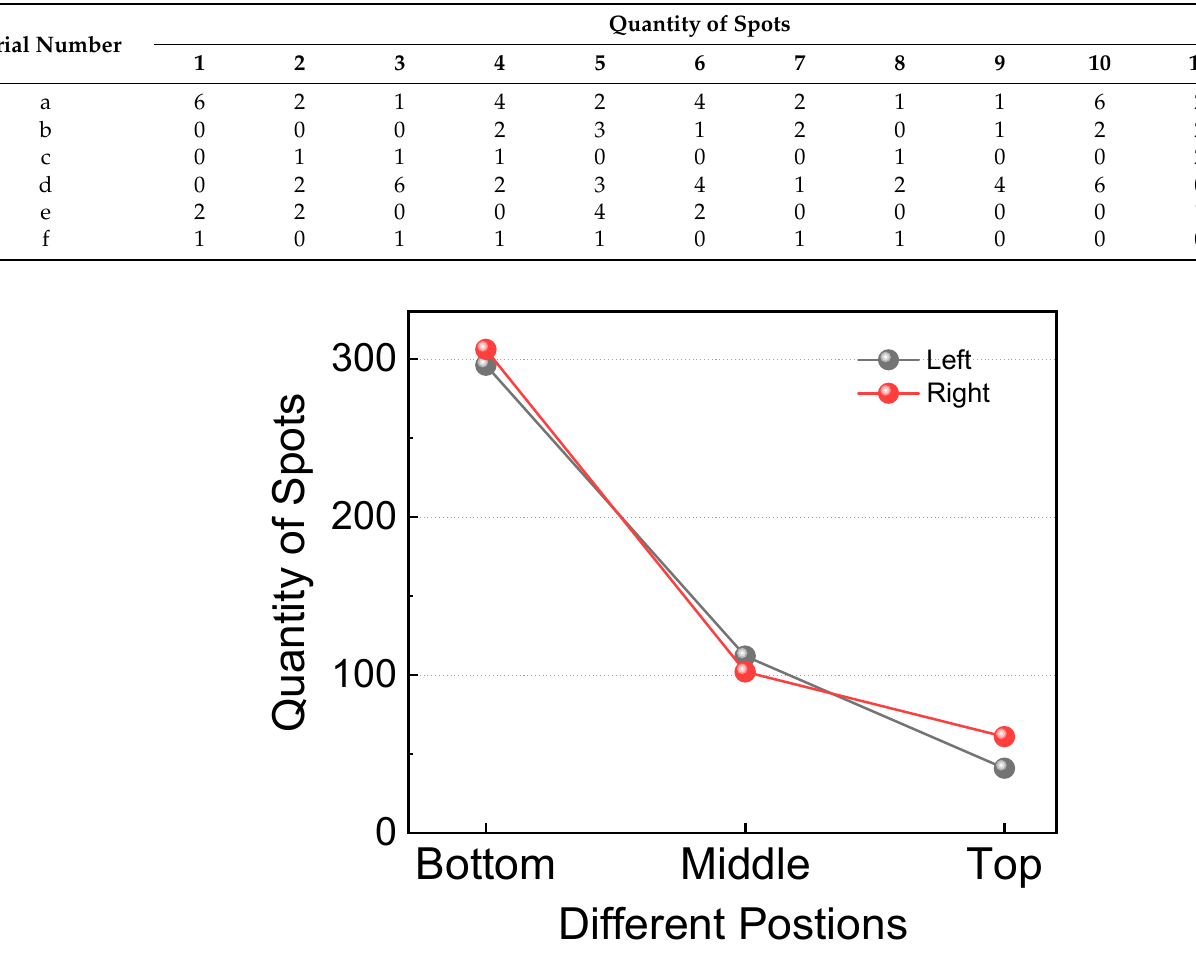
Figure 9. Model diagram of the sampling method. The quantity results of black spots at different sampling points are shown in Table 2.